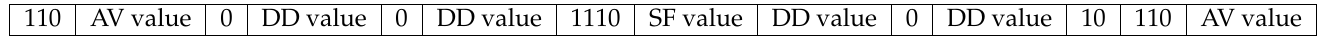
Table 2. Encoding data block row